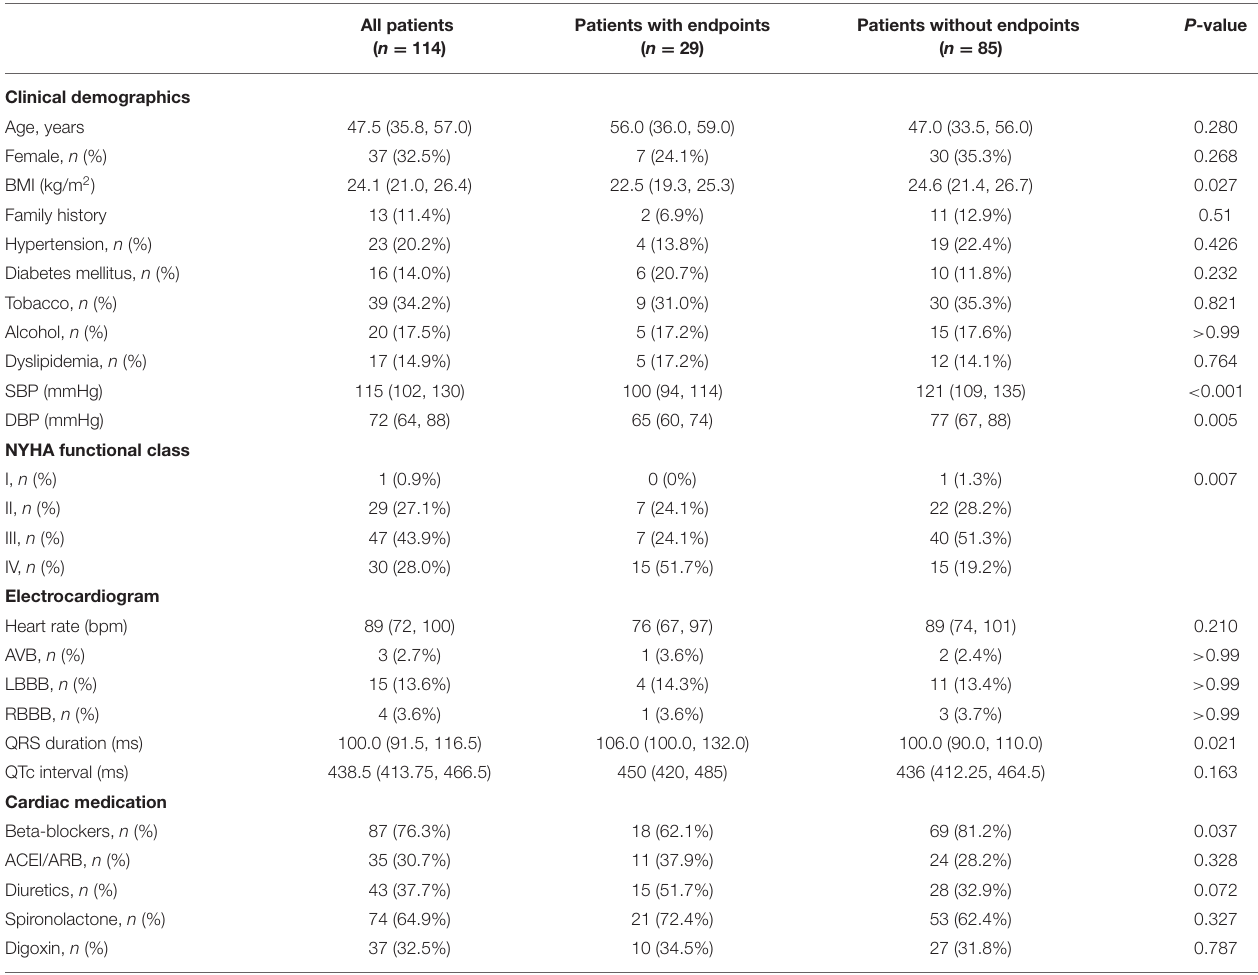
TABLE 1 | Baseline clinical characteristics.